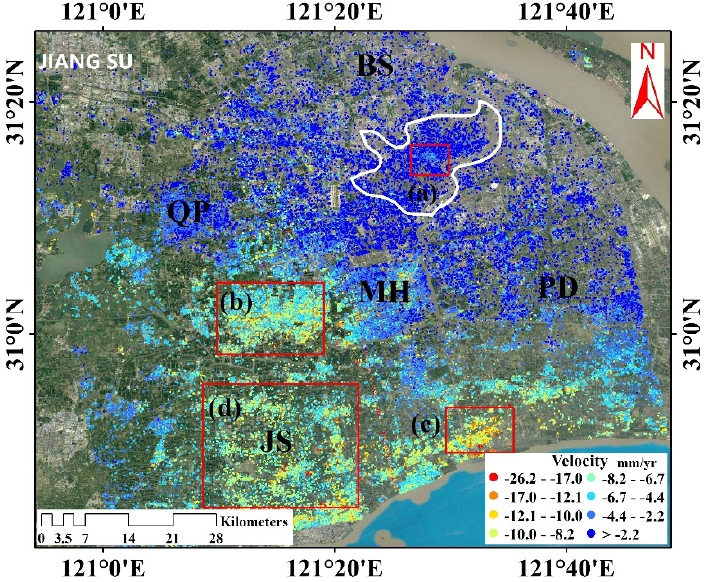
Figure 4. Surface subsidence rate map in the study area obtained by PSInSAR; The white curve area denotes the urban area of Shanghai (SQ); The red rectangles depict characteristic areas.